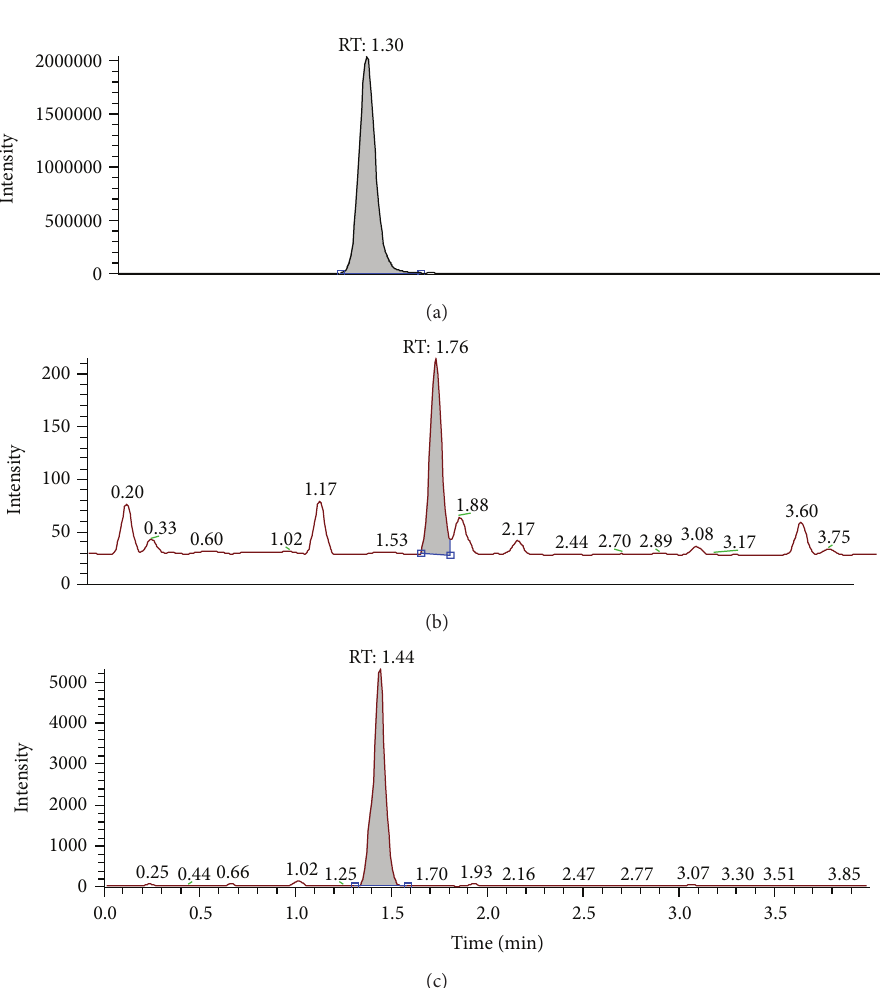
Figure 3: Representative chromatograms of rat plasma spiked with PD (50 ng/mL, LLOQ), PD3 (50ng/mL, LLOQ), and IS ((a) PD, (b) PD3, and (c)